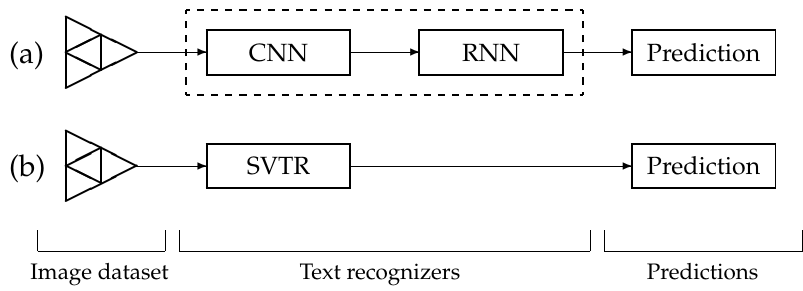
Figure 2. Modern text recognizers using (a) CRNN and (b) SVTR models, adapted from